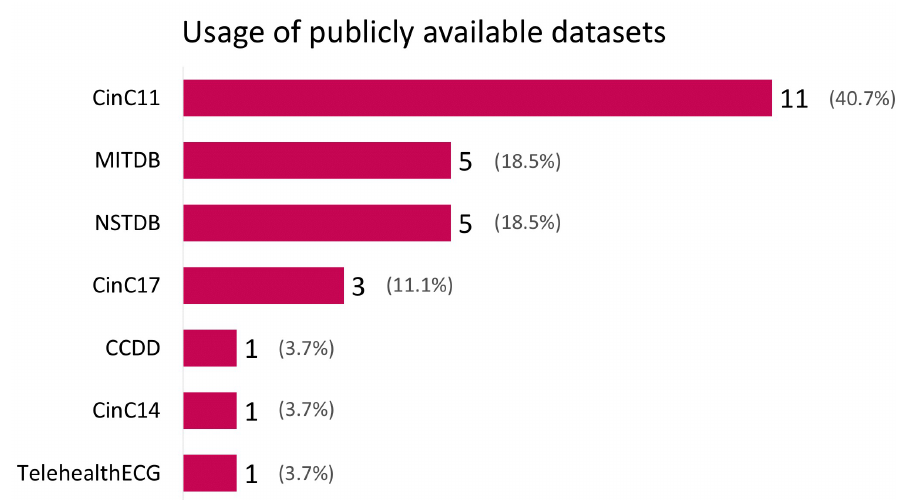
Figure 3. Bar plot of the publicly available datasets used by studies published between January 2012 and January 2022. The dataset most used was CinC11 [4]. The percentages represent the percentage of the dataset out of the total number of datasets used in the